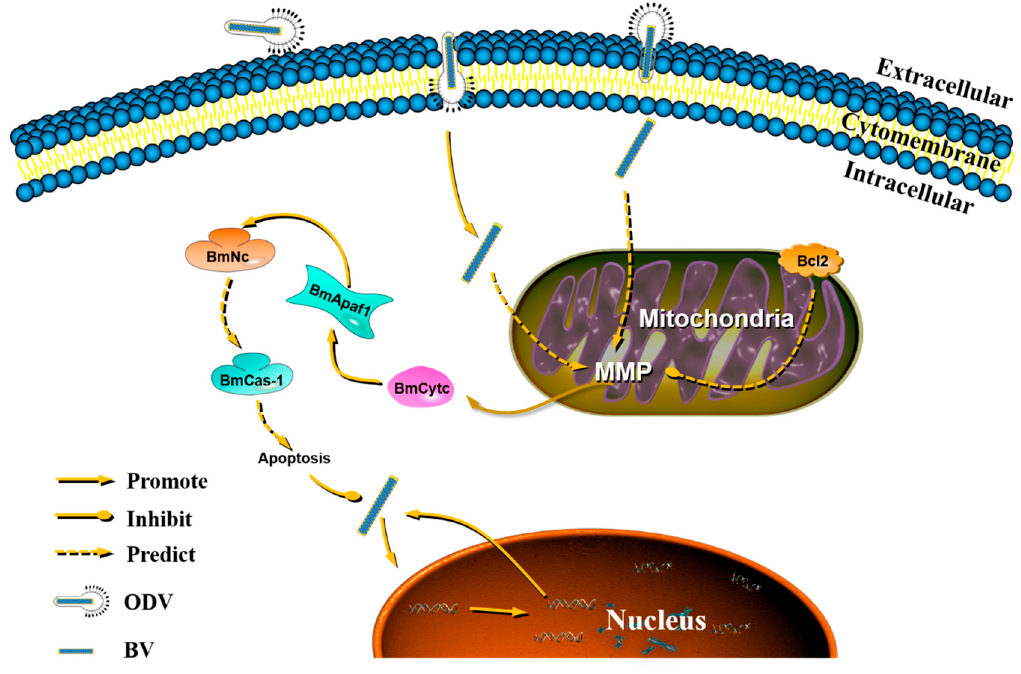
Figure8. TheproposedfunctionofBmApaf-1inresponseagainstBmNPVinfectionbythemitochondrial Figure 8. The proposed function of BmApaf-1 in response against BmNPV infection by the apoptosis pathway. MMP, mitochondrial membrane mitochondrial apoptosis pathway. MMP, mitochondrial membrane potential.